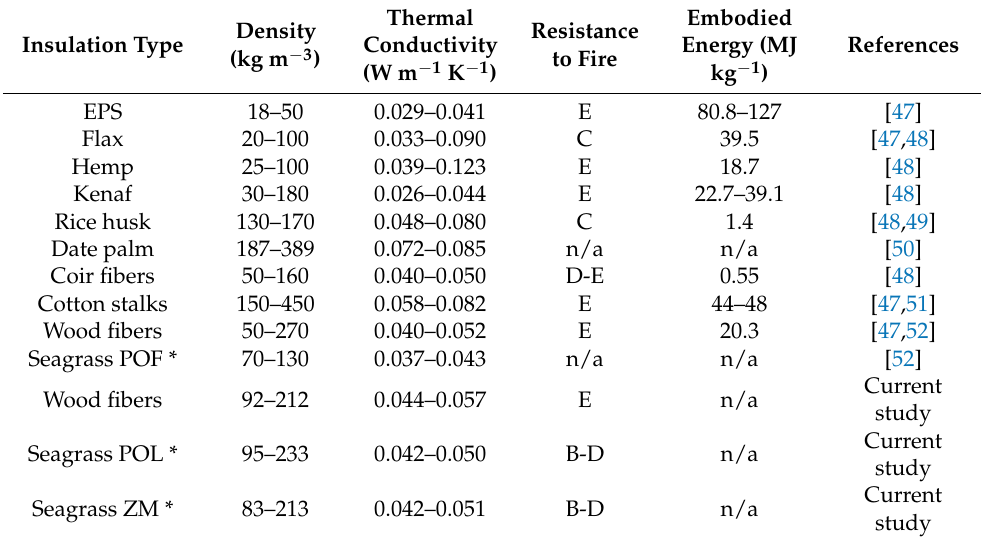
Table 6. The thermal conductivity, resistance to fire, and the embodied energy for various types of insulation at a specific range of